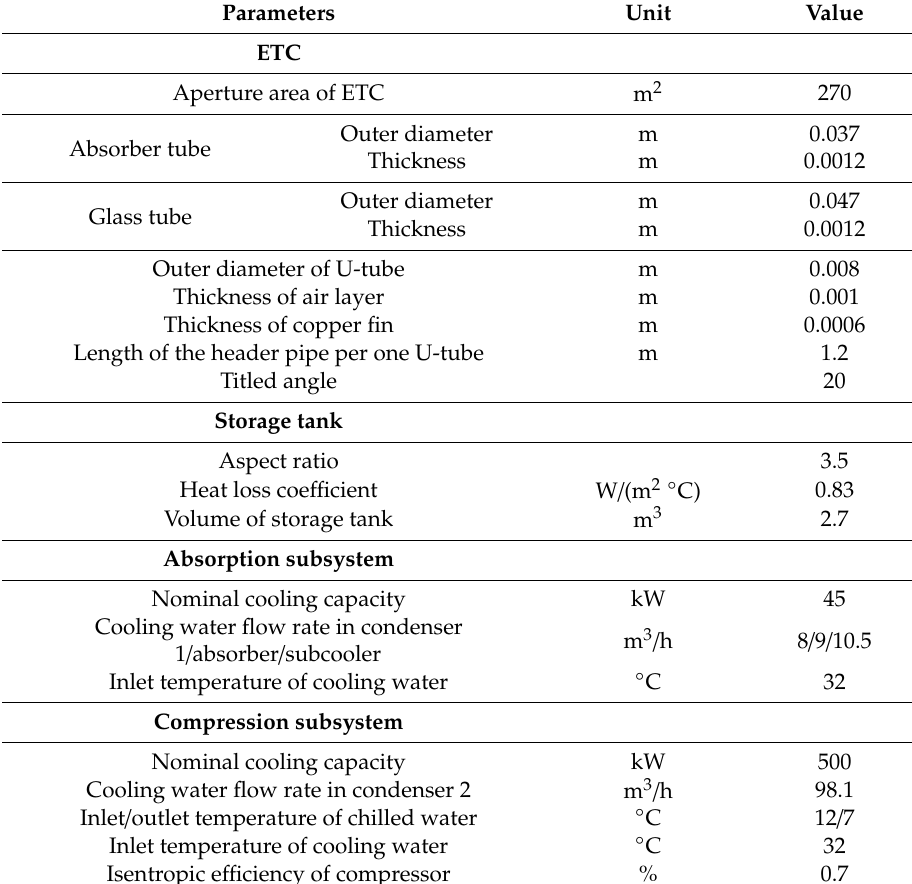
Figure 5. Cooling load. Table 2. Design and operation parameters of SASCHCS.